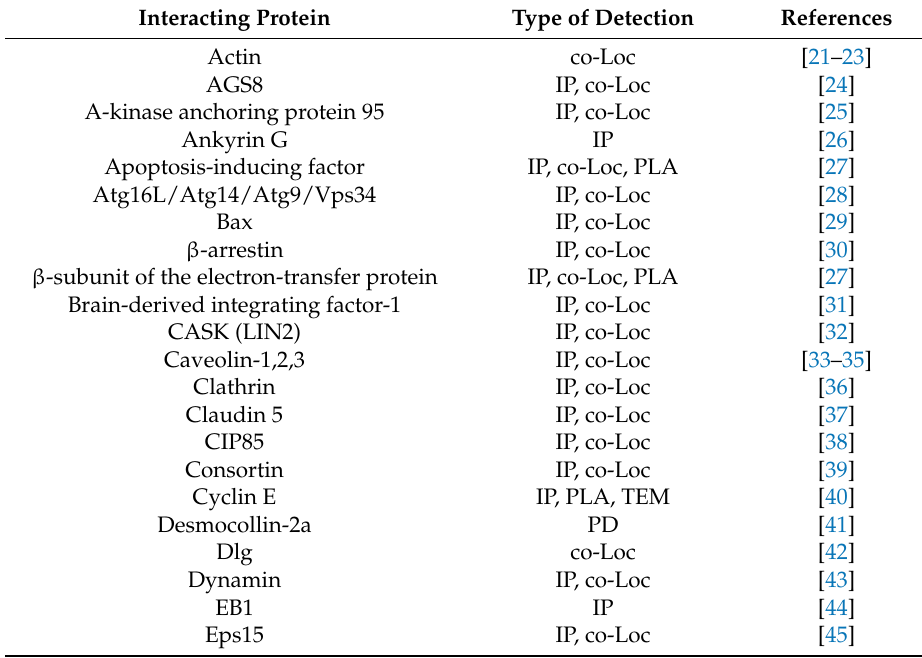
Table 1. Proteins suggested to interact with Cx43, but where no evidence currently exist for a direct protein–protein interaction. Abbreviations: IP, immunoprecipitation; co-Loc, co-localization; PLA, proximity ligation assay; TEM, transmission electron microscopy; PD, pull-down; IV, in vitro assay; FW,